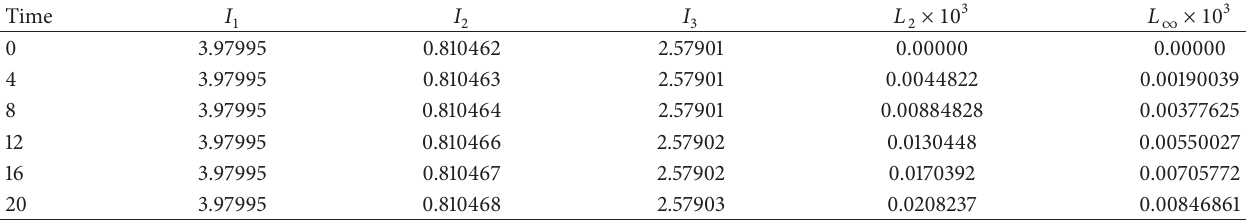
Table 3: Table comparing values obtained from the implicit scheme (35) to the single solitary wave solution (8) for 𝑥 0 = 0 and 𝑣 = 0.1 , for 𝑥 ∈ [−50,70] , and taking 𝑛 = 5000 and Δ𝑡 = 0.0001 .